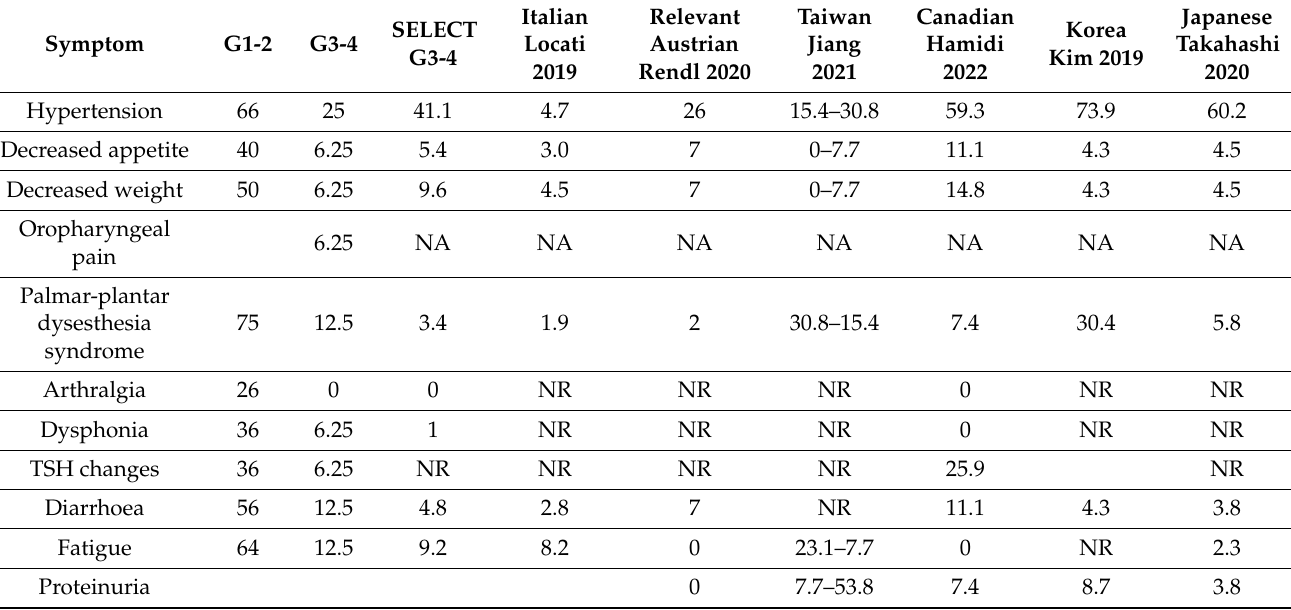
Table 4. Safety of the treatment reported in clinical trials and real-world